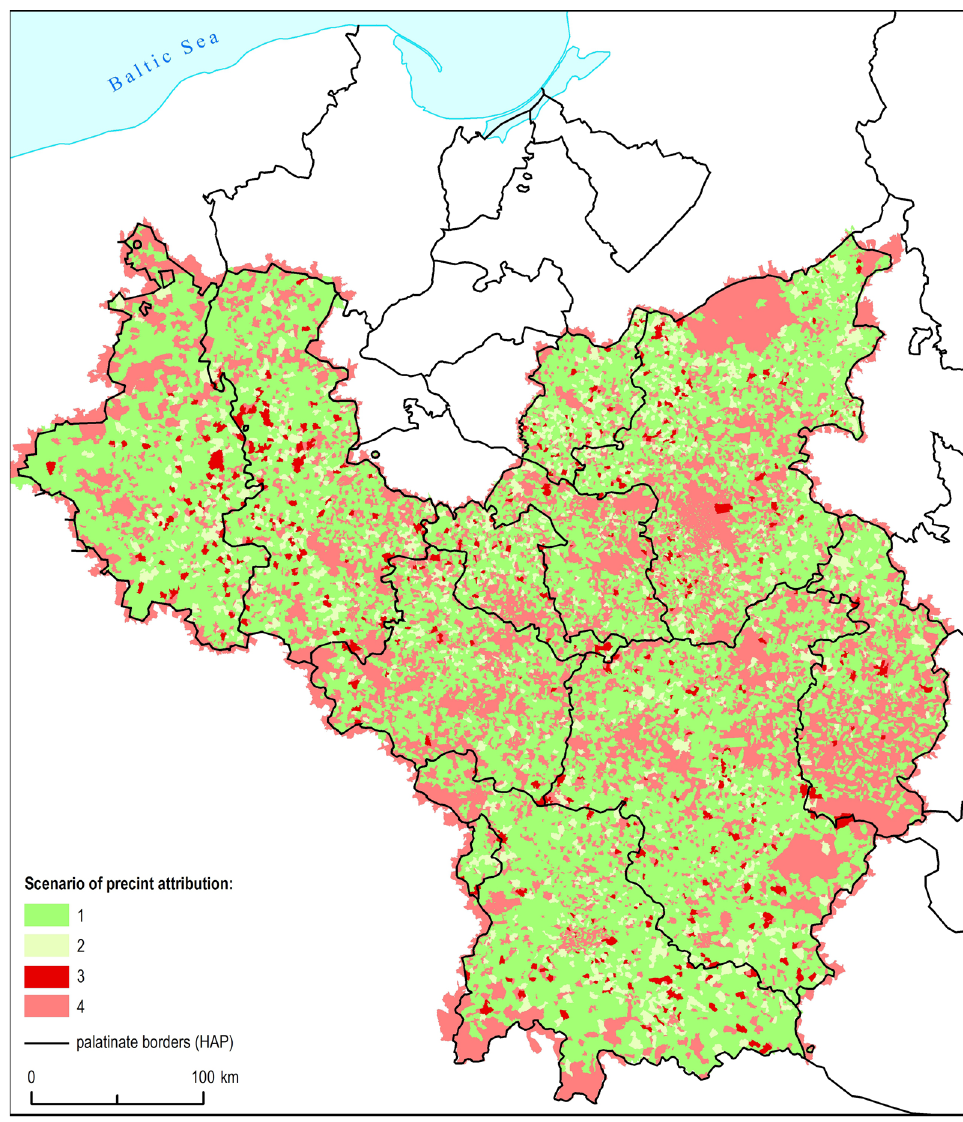
Fig. 1. Assigning attributes of historical administrative belonging to